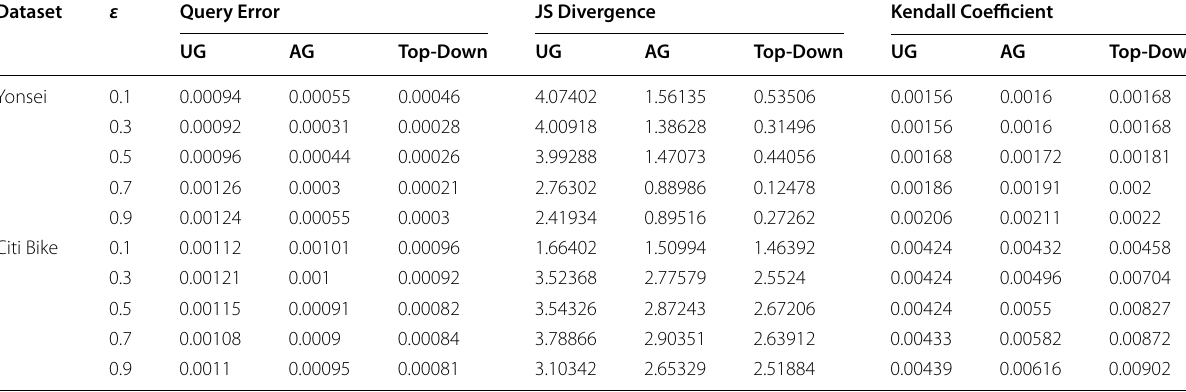
Table 4 Privacy protection average performance of the total differential privacy budget